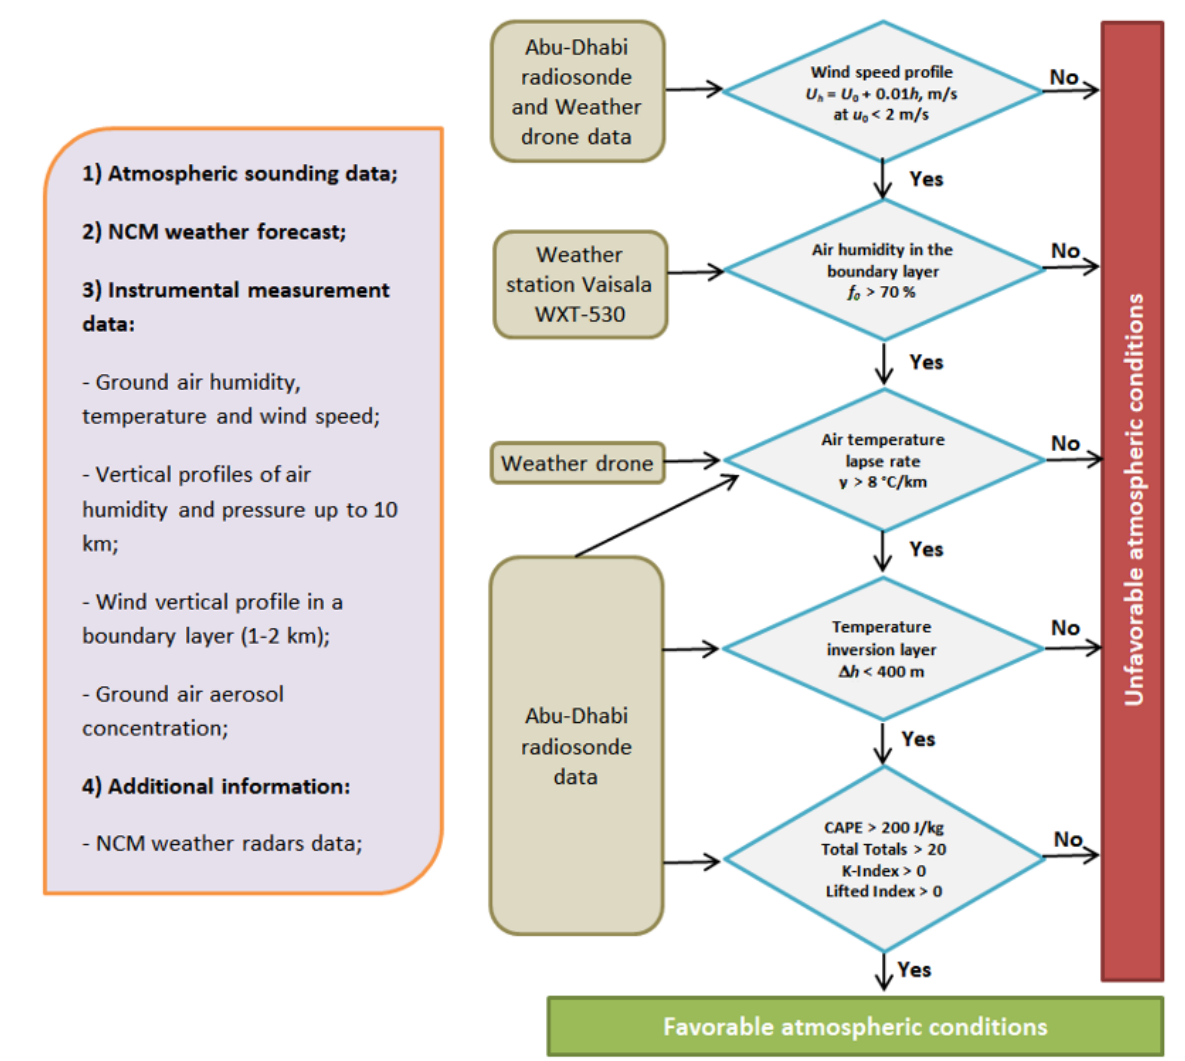
Figure 4. Criteria for choosing days with favorable conditions.